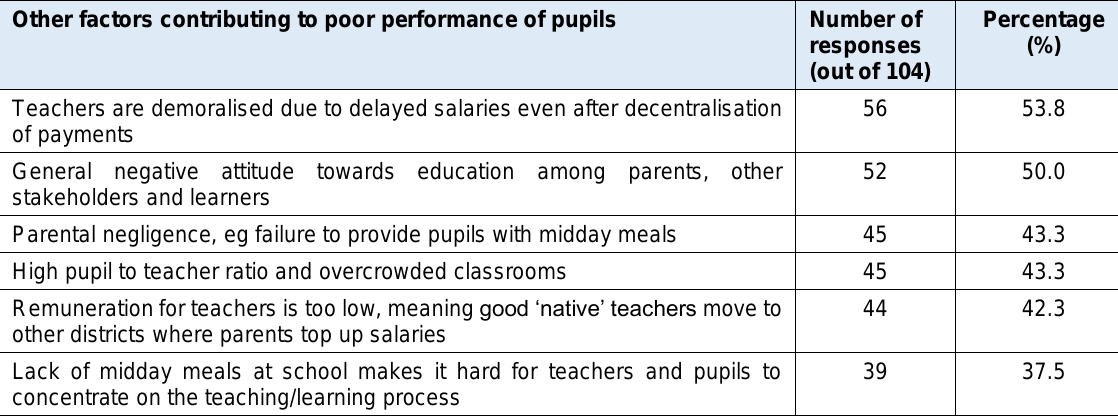
Table 3: Other factors affecting performance in primary